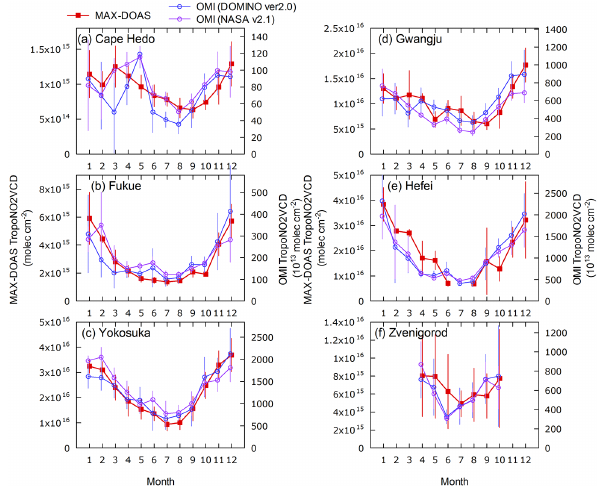
Figure 11. Seasonality comparisons for TropoNO2VCD values de- rived from MAX-DOAS and satellite observations. MAX-DOAS data from the hours of satellite observations were used. The error bars represent variability in the monthly average TropoNO2VCD values over the studied